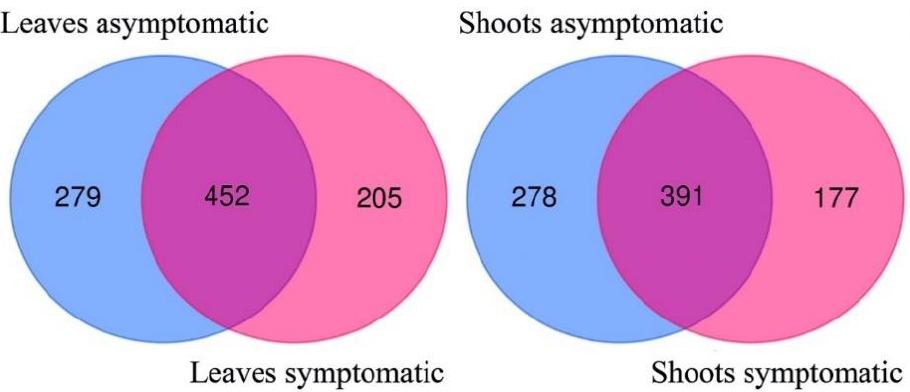
Figure 3. Venn diagrams showing the diversity and overlap of fungal taxa in asymptomatic and symptomatic samples of leaves and shoots of Fraxinus excelsior .